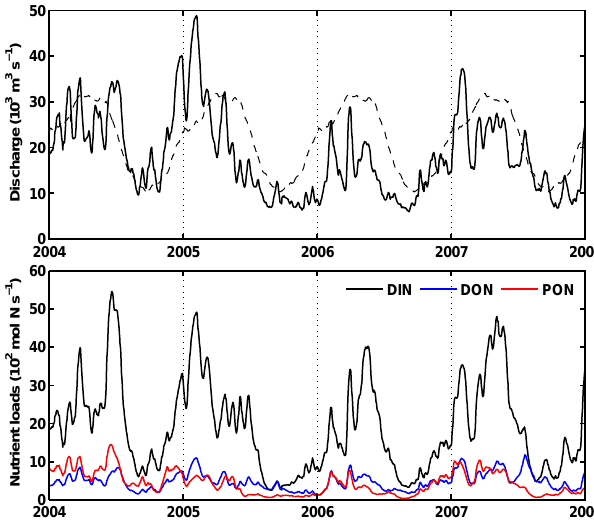
Figure 2. Mississippi and Atchafalaya River freshwater discharge (upper panel) and nutrient loads (lower panel) in 2004–2007. The dashed line indicates the long-term climatology